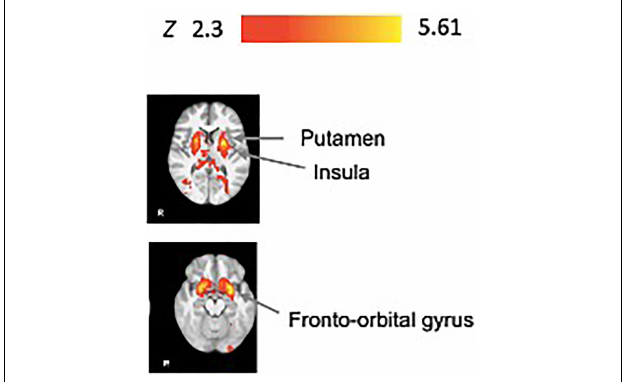
FIGURE 4 | Performance-specific task fMRI activity. Brain activity associated with performance improvements during practice ( N = 34). We show significant associations in the putamen, fronto-orbital gyrus, amygdala, insula, and uncinate fasciculus. All results have been corrected for multiple comparisons ( p <